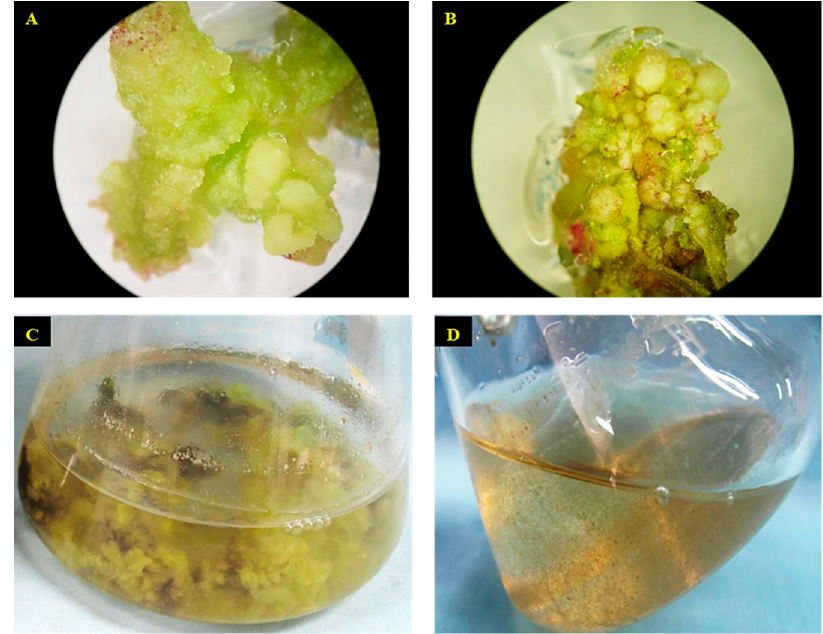
Figure 1. Induction of friable callus after two weeks ( A ) and four weeks ( B ); friable callus cultured in liquid medium with cells deposited on the walls of the flask ( C ); cell suspension cultures derived from callus cultures ( D ).